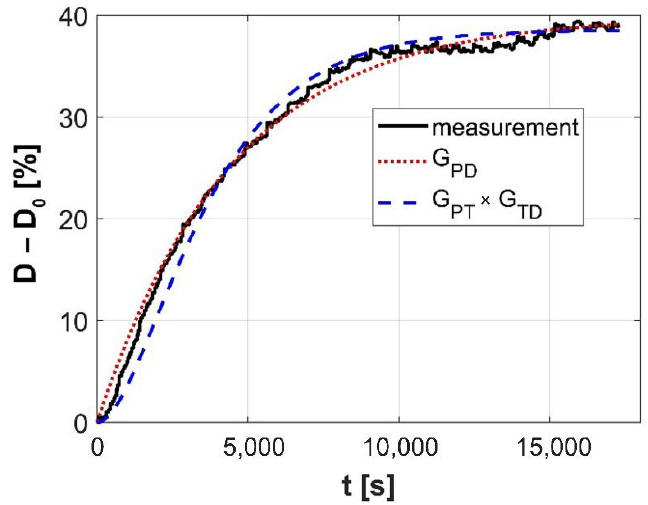
Figure 23. Responses of the object of research and two models to the jumping force with a power of 1000 W (D and D0 indicate the current dryness of the tape and its initial dryness at the start of the experiment, respectively).